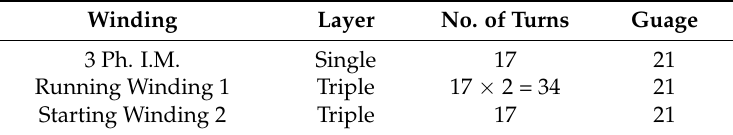
Table 8. Welding transformer winding